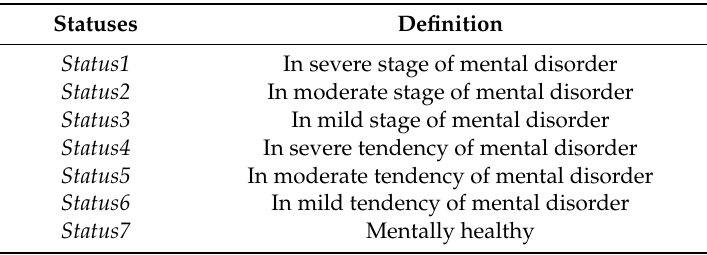
Table 4. 7 Mental health